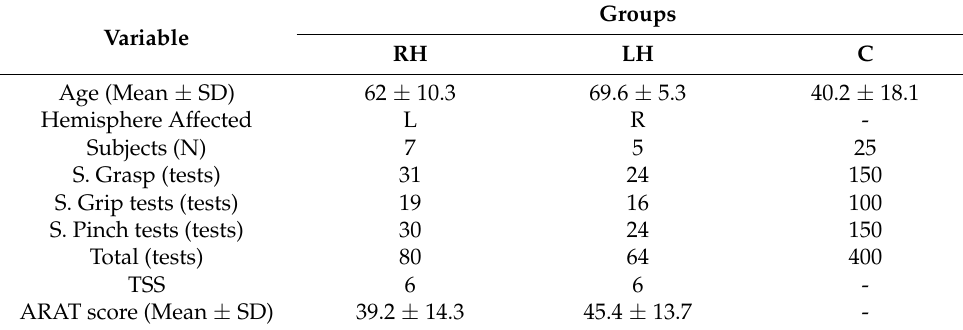
Table 1. Characteristics of the